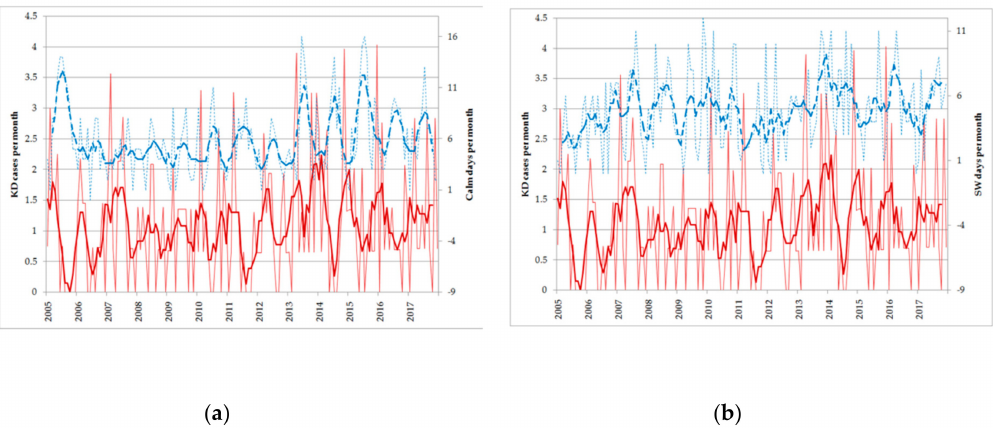
Figure 5. ( a ) Number of KD onsets per month as a function of time in Emilia (thin red line, left axis) together with its five month running mean (thick red line), and number of calm days per month in Emilia (thin dashed blue line, right axis) with its five month running mean (thick dashed blue line). ( b ) Same as panel a but blue lines refer to the number of SW wind per month in